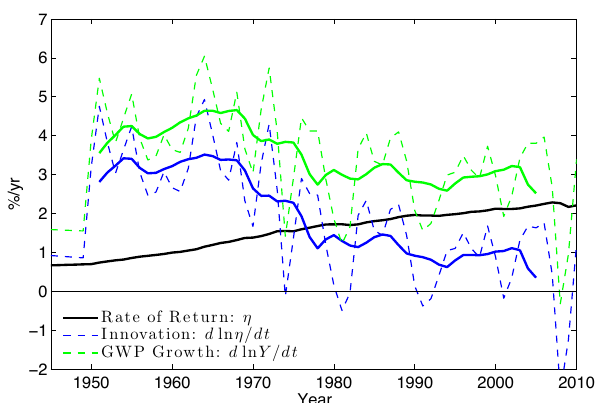
Figure 4. Time series of the rate of return, innovation, and the GWP growth rate, evaluated at global scales and expressed in percent per year. Solid lines represent a running decadal mean (see Garrett, 2014, for